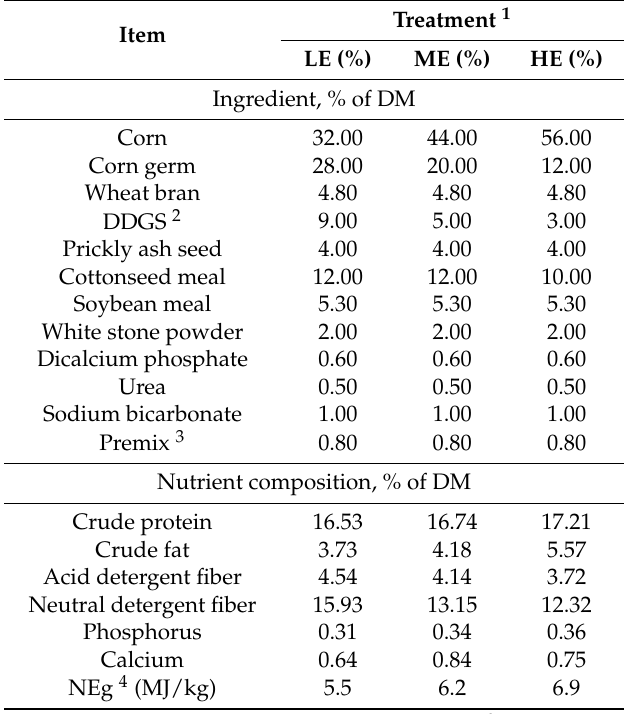
Table 1. Nutrients composition of three energy diets used during experiment. Treatment Item